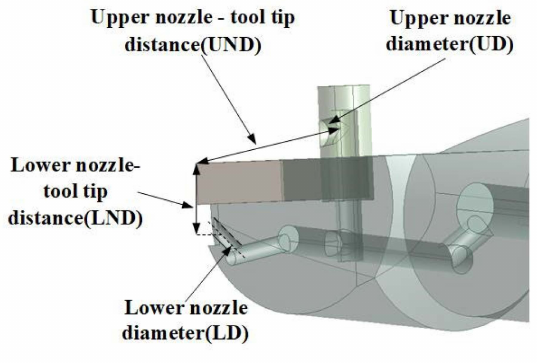
Figure 5. Geometric parameters to be optimized of spray cooling structures.